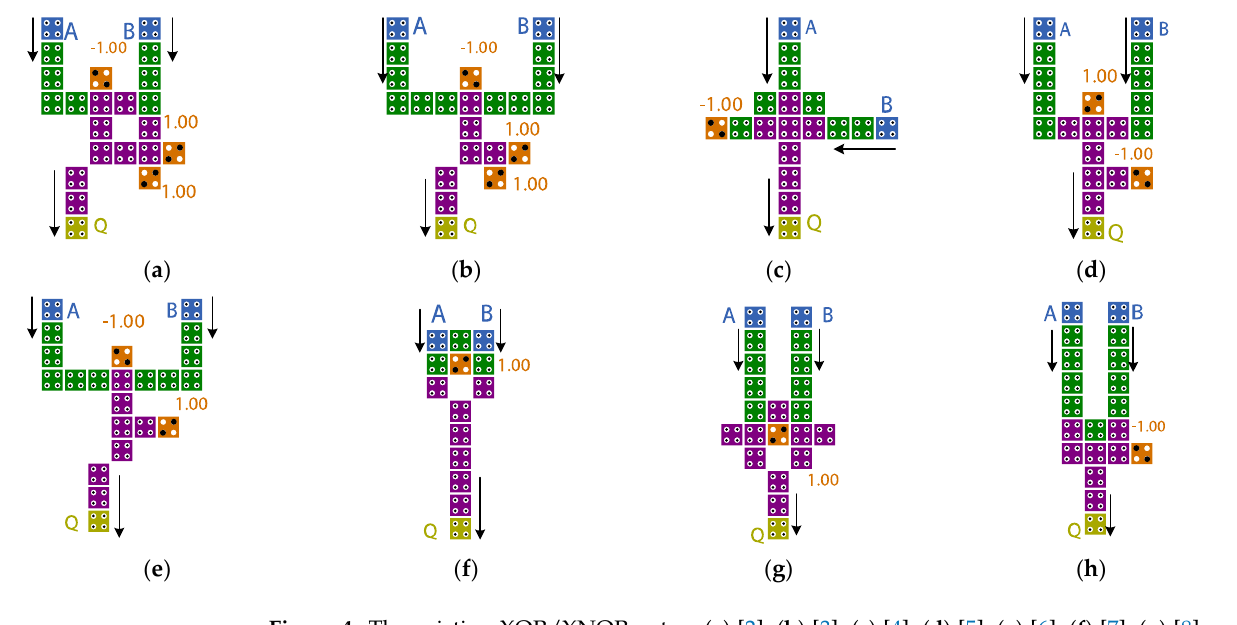
Figure 4. The existing XOR/XNOR gates. ( a ) [2], ( b ) [3], ( c ) [4], ( d ) [5], ( e ) [6], ( f ) [7], ( g ) [8], and ( h ) [9].